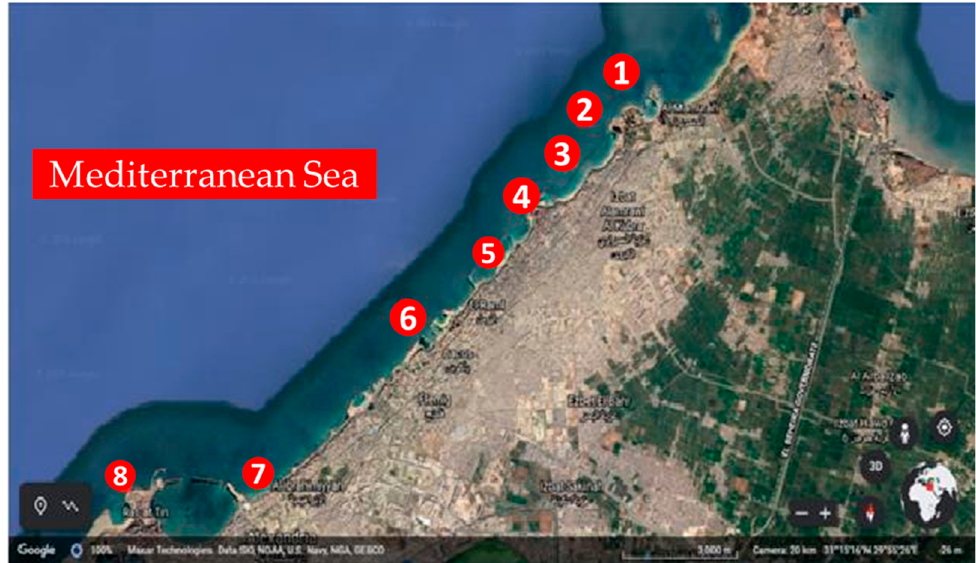
Figure 1. Map of sampling sites during the period study (1: El-Montaza; 2: El-Mandra; 3: